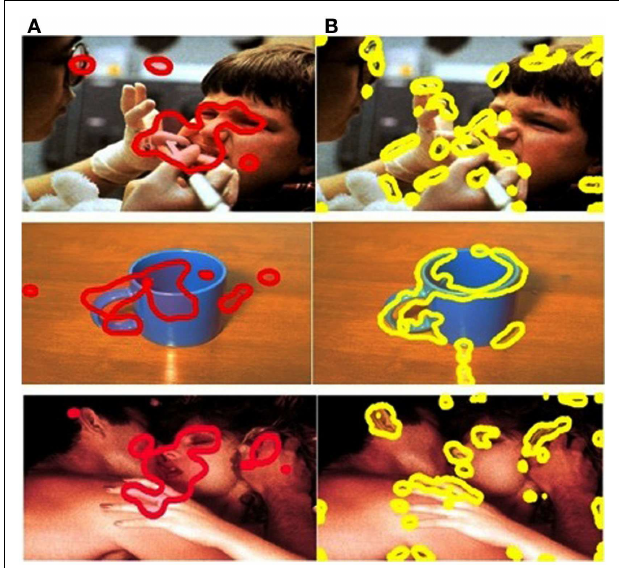
FIGURE 2 | Comparison of ROIs in example positive, negative, and neutral images. Column (A) affective ROIs. (B) Visually salient